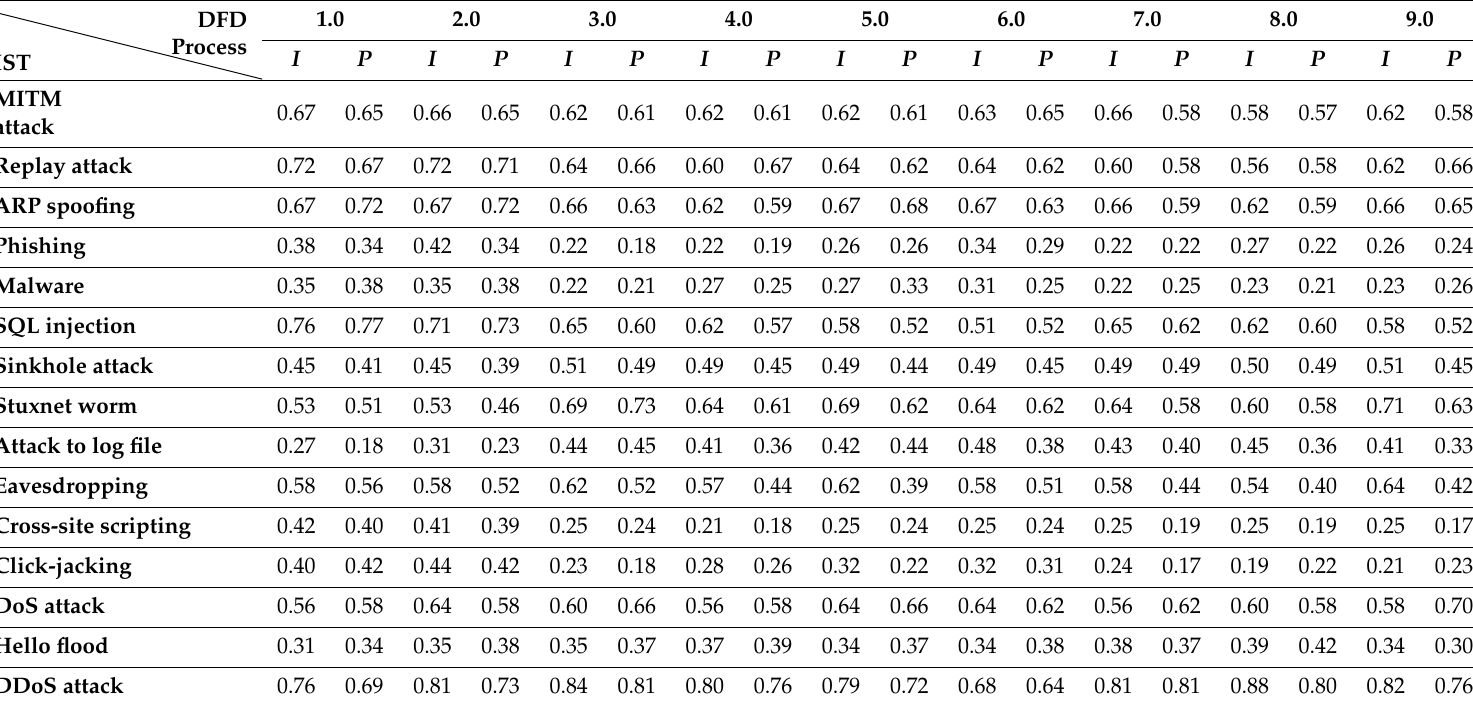
Table 5. The IST evaluation scores for DFD Process of the ELB